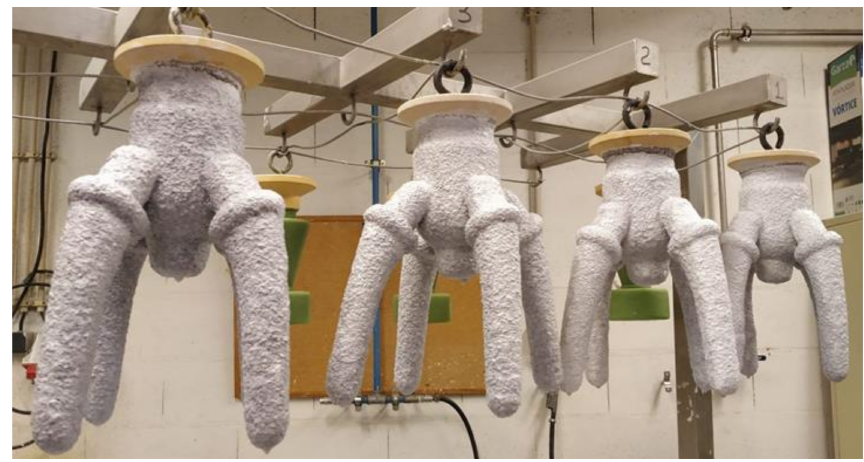
Figure 10. Hip prostheses shell mould.